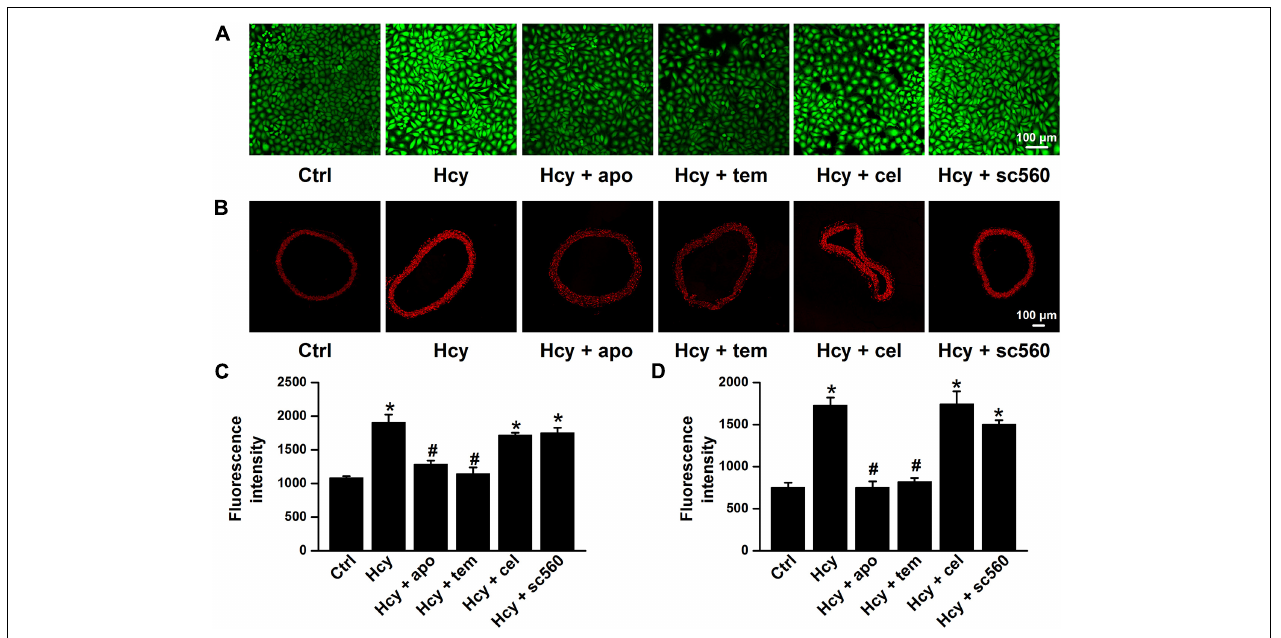
FIGURE 3 | NADPH oxidase inhibitor or TEMPOL reverses exogenous Hcy-induced ROS generation in both HUVECs and mouse aorta. (A,B) Representative confocal microscopy images, taken from HUVECs (A) or aorta (B) , under control condition (Ctrl) or treated with 100 µ M Hcy in the absence or in the presence of 100 µ M apocynin (apo), 100 µ M TEMPOL (tem), 3 µ M celecoxib (cel), and 0.3 µ M sc560 for 6 h, respectively. (C,D) Summarized fluorescent intensities in HUVECs (DCF staining) or aorta (DHE staining), measured from the data shown in (A,B) , reflect the ROS levels in HUVECs or aorta. Data are means ± SEM of six individual experiments. * P < 0.05 vs. ctrl; # P < 0.05 vs.